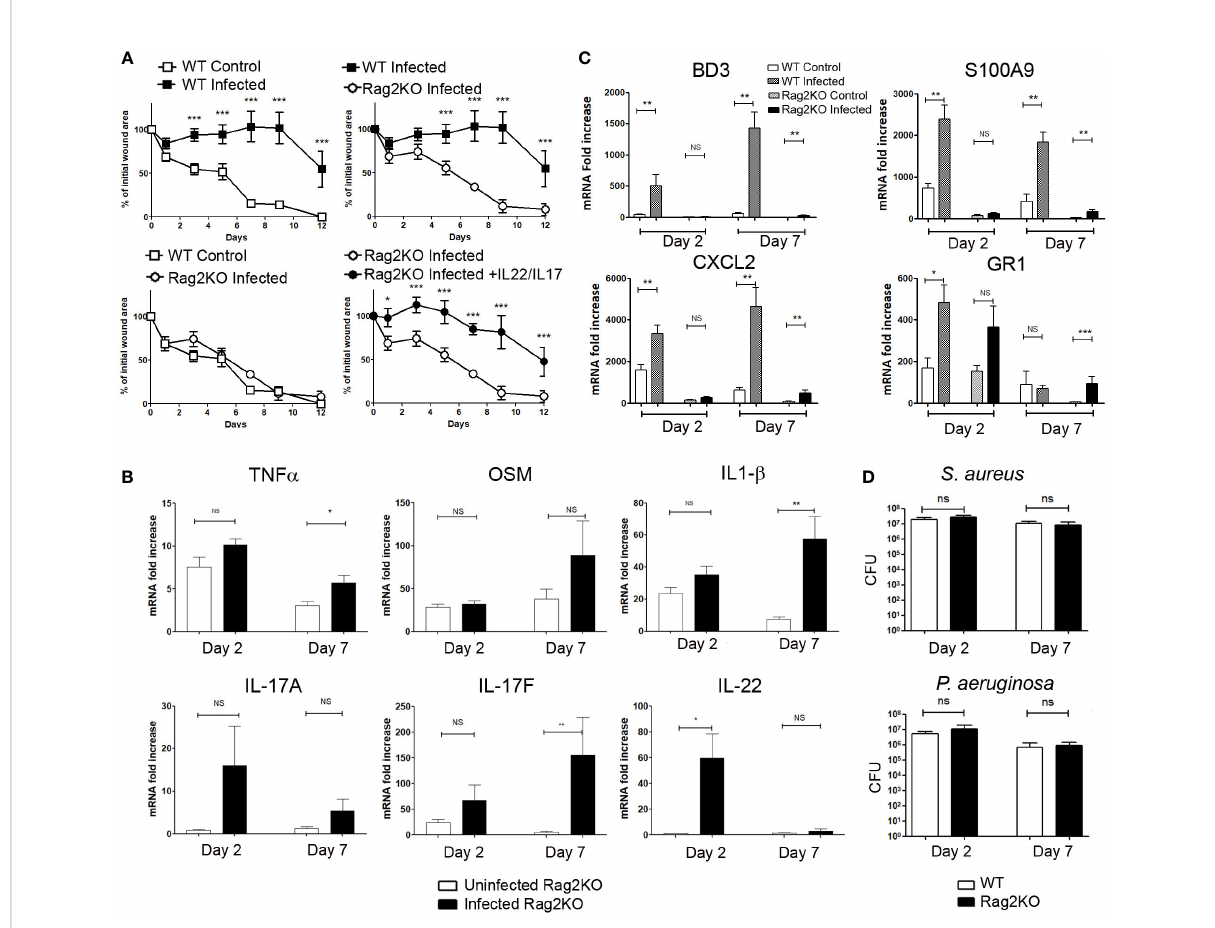
FIGURE 4 Wound closure is not delayed in infected skin excisional wounds of Rag2KO mice, and exogenous IL-17A/F and IL-22 make up for this delay. Time course of wound closure expressed as the percentage of initial wound area at each time point, (A) in the uninfected ( □ ) or infected ( ■ ) wounds of WT mice, infected Rag2KO mice ( ○ ) or infected Rag2KO mice with exogenous IL-17A and IL-22 ( ● ). The data are expressed as the mean +/- SEM of 6 independent experiments, with at least 4 mice/group; ** p<0.01, ***p<0.001. ns, not signi fi cant. (B) Cytokine mRNA expression into control or infected wounds of Rag2KO mice was determined by RT-qPCR at day 2 and day 7. Each bar represents the mRNA fold increase over normal skin, in control-wounded skin (white) or infected wounded skin (black). The data correspond to the mean +/- SEM of 3 independent experiments; * p <0.05, ** p <0.01, *** p <0.001. ns, not signi fi cant. (C) BD3, S100A9, CXCL2, GR1 mRNA expression into control or infected wounds of WT and Rag2KO mice were determined by RT-qPCR at day 2 and day 7. Each bar represents the mRNA fold increase over normal skin in control-wounded WT mice skin (white), infected wounded WT mice skin (hatched), in control-wounded Rag2KO mice skin (dotted), infected wounded Rag2KO mice skin (black). The data correspond to the mean +/- SEM of 3 independent experiments; * p <0.05, ** p <0.01, *** p <0.001. ns, not signi fi cant. (D) The bacterial load after inoculation in skin wounds is unchanged between WT and Rag2KO mice. CFU determination for S. aureus and P. aeruginosa in wounded WT and Rag2KO mice skin 2 and 7 days after inoculation of S. aureus and P. aeruginosa . The data correspond to the mean +/- SEM of 3 independent experiments, ns, not signi fi